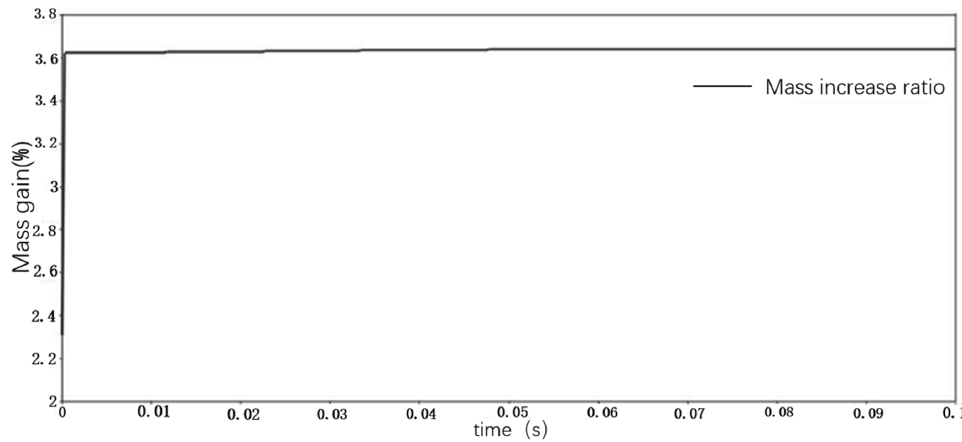
Figure 11. Percentage of mass increase.